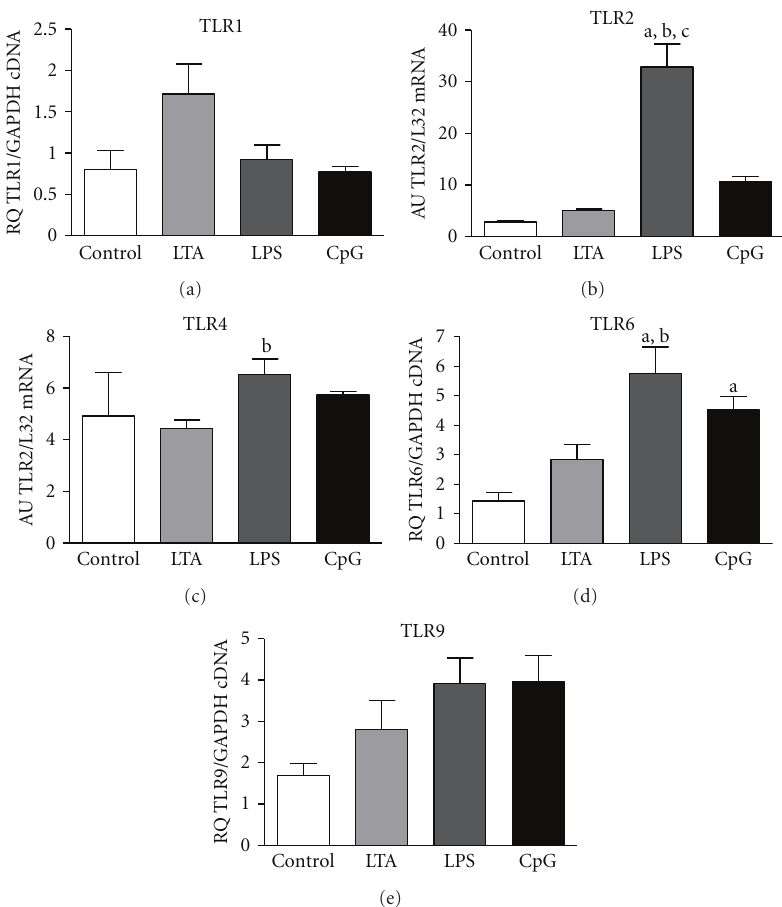
Figure 2: TLR mRNA expression. Analysis of TLR1, 2, 4, 6, and 9 in control, LTA-, LPS-, and CpG-ODN-stimulated pulmonary tissue (TLR1/6/9 detected with RT-qPCR, values depicted as relative quotient (RQ) to housekeeping gene; TLR2/4 detected with RPA, values expressed as arbitrary units (AU) normalized to L32 mRNA,). Alphabetic characters indicate P -values < . 05 from Bonferroni post hoc testing (a = versus control, b = versus LTA, c = versus CpG-ODN; M ± SEM; n =